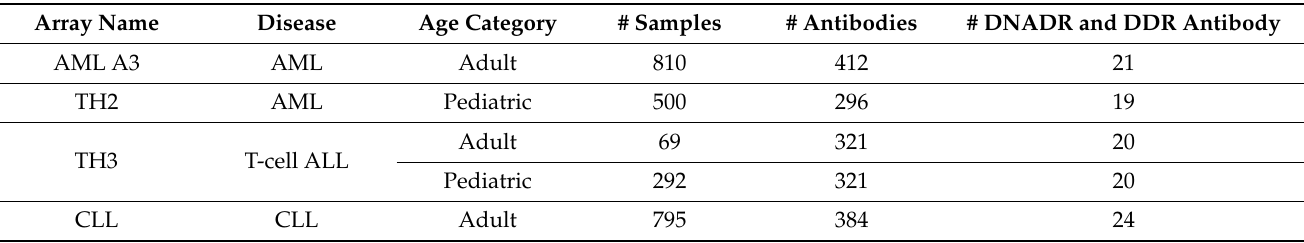
Table 1. Summary overview of the RPPA arrays utilizing DNADR and DDR antibodies for acute and chronic leukemia